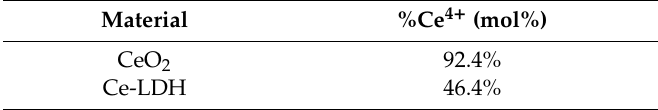
Table 2. Ce 4+ fraction of the CeO 2 and Ce-LDH materials as determined by iodometry. Table 2. Ce 4 + fraction of the CeO 2 and Ce-LDH materials as determined by